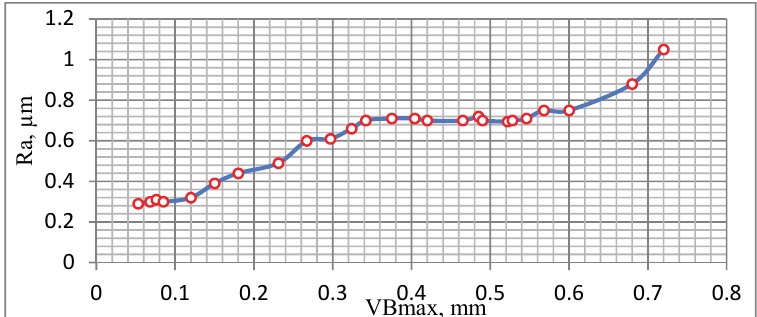
Fig. 15. Flank wear effect on roughness when machining at a 439.6m/min and a feed per of 0.114 mm tooth